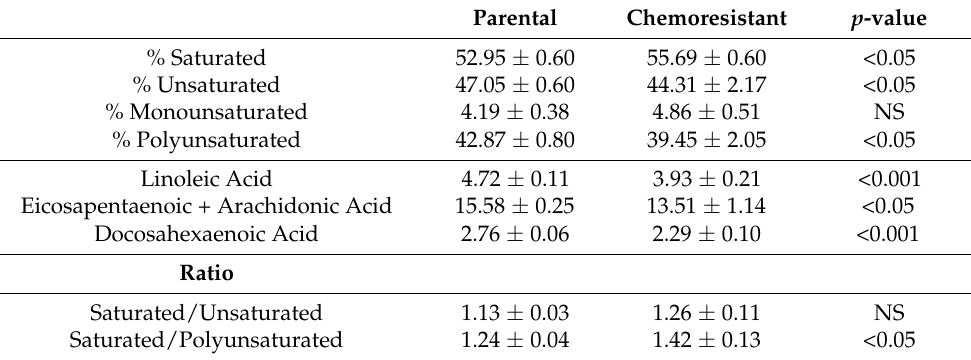
Table 1. Fatty acid profile of the lipid extracts from PTX-res and parental cells. Values are expressed in percentages of total lipids (mol/100 mol of Total Fatty Acids) and are means ±